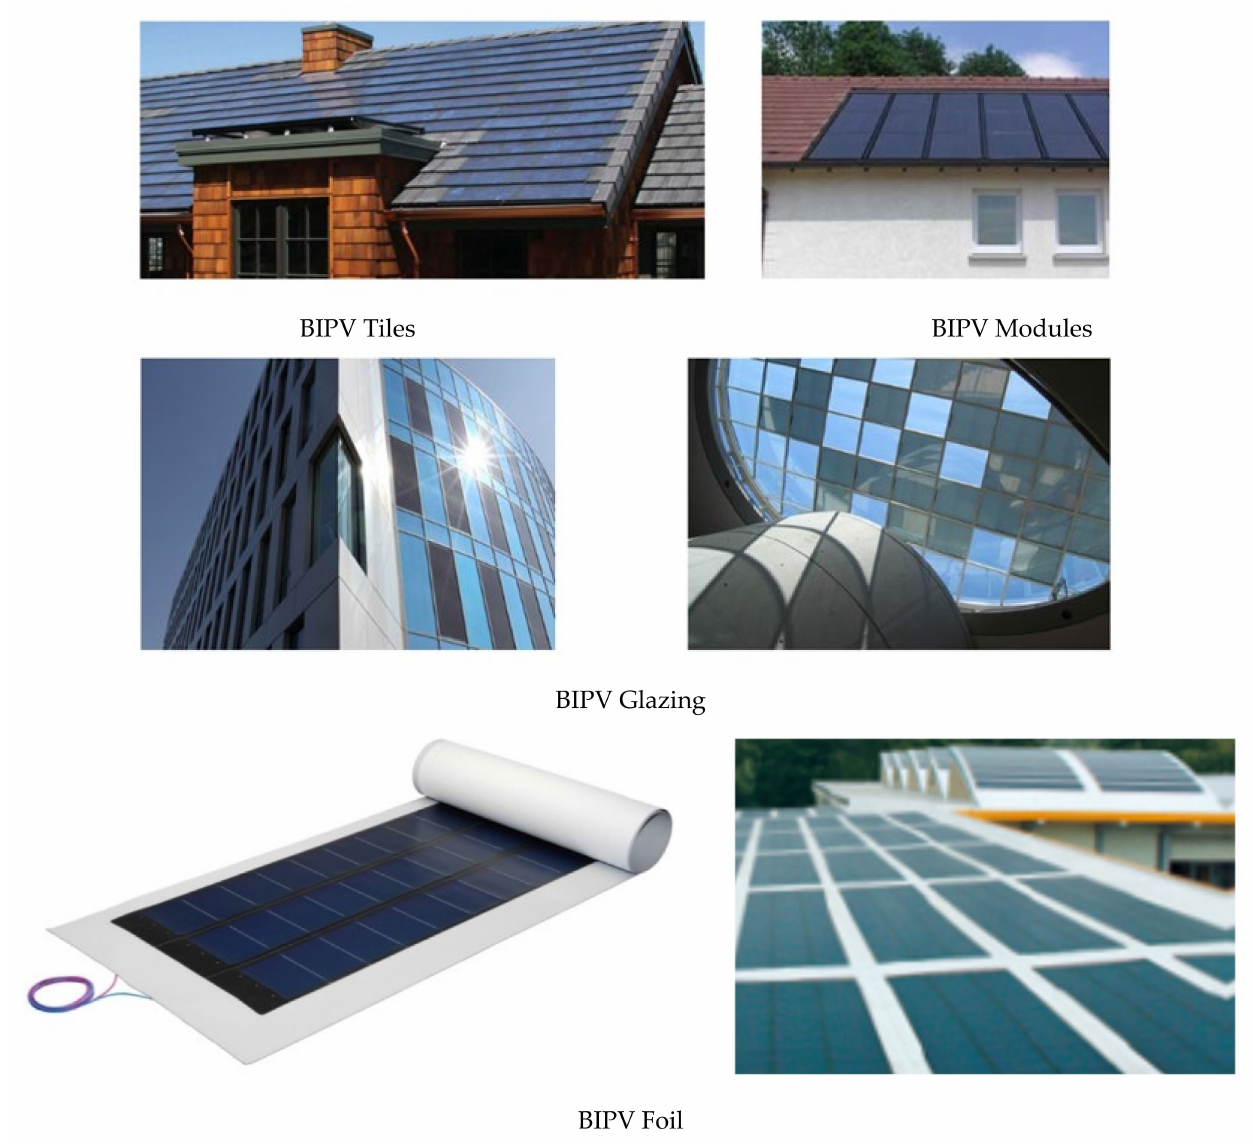
Figure 3. Examples of BIPV systems available on the